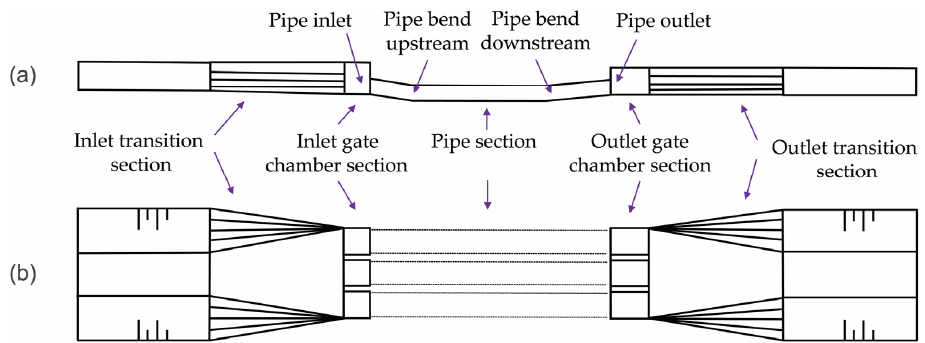
Figure 2. Scheme of an inverted siphon: ( a ) profile view and ( b ) plan view. Water gauges are installed at the inlets and outlets of the crossing water-conveyance structures, located upstream of the inlet transition section and downstream of the outlet transition section, and the water level is read manually through a camera. There are 59 crossing water-conveyance structures with control gates, near which pressure water level